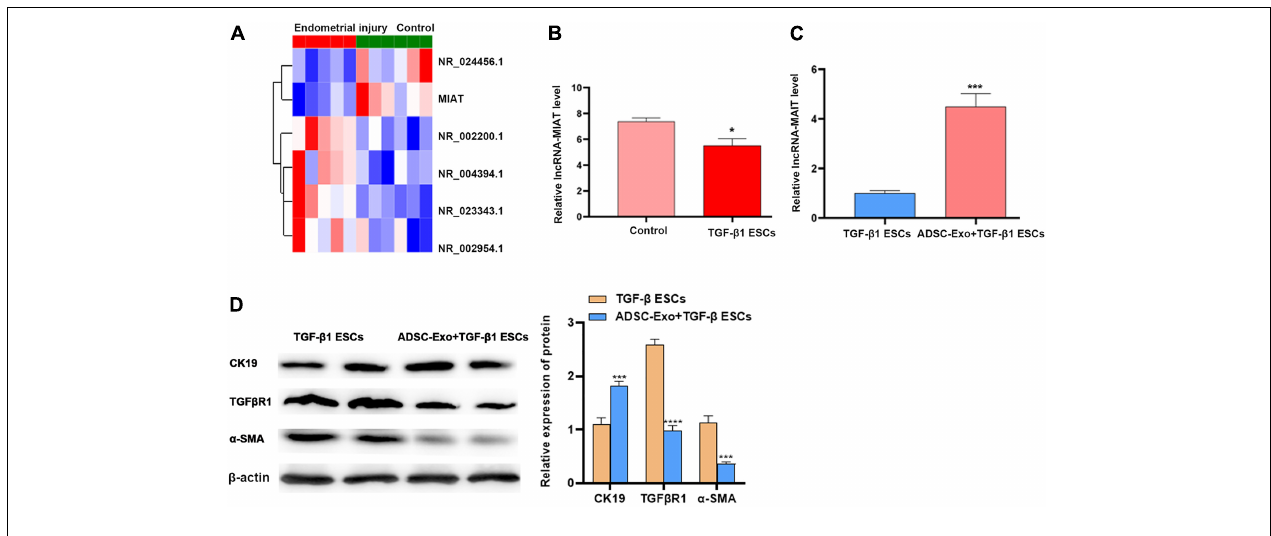
FIGURE 2 | LncRNA-MIAT in ADSC-Exos alleviates endometrial fibrosis. (A) Thermal map analysis of the top differentially expressed lncRNAs in endometrial samples from patients with endometrial injury. (B) qPCR analysis of the lncRNA-MIAT expression level in TGF- β 1-induced ESC injury. (C) qPCR analysis of the lncRNA-MIAT expression level in TGF- β 1-induced ESC injury cocultured with or without ADSC-Exos. (D) Western blot analysis of CK19, TGF β R1, and α -SMA protein expression in TGF- β 1-induced ESC injury co-cultured with or without ADSC-Exos. Data are presented as the mean ± SD ( n = 3). Two-tailed unpaired Student’s t -test, * P < 0.05; *** P < 0.001; **** P < 0.0001. ADSC-Exos, adipose-derived mesenchymal stem cells-exosome; qPCR, real time quantitative PCR; TGF- β 1, transforming growth factor- β 1; ESC, endometrial epithelial cells; CK19, cytokeratin 19; TGF β R1, homo sapiens transforming growth factor beta receptor 1; α -SMA, alpha smooth muscle Actin. SD, standard